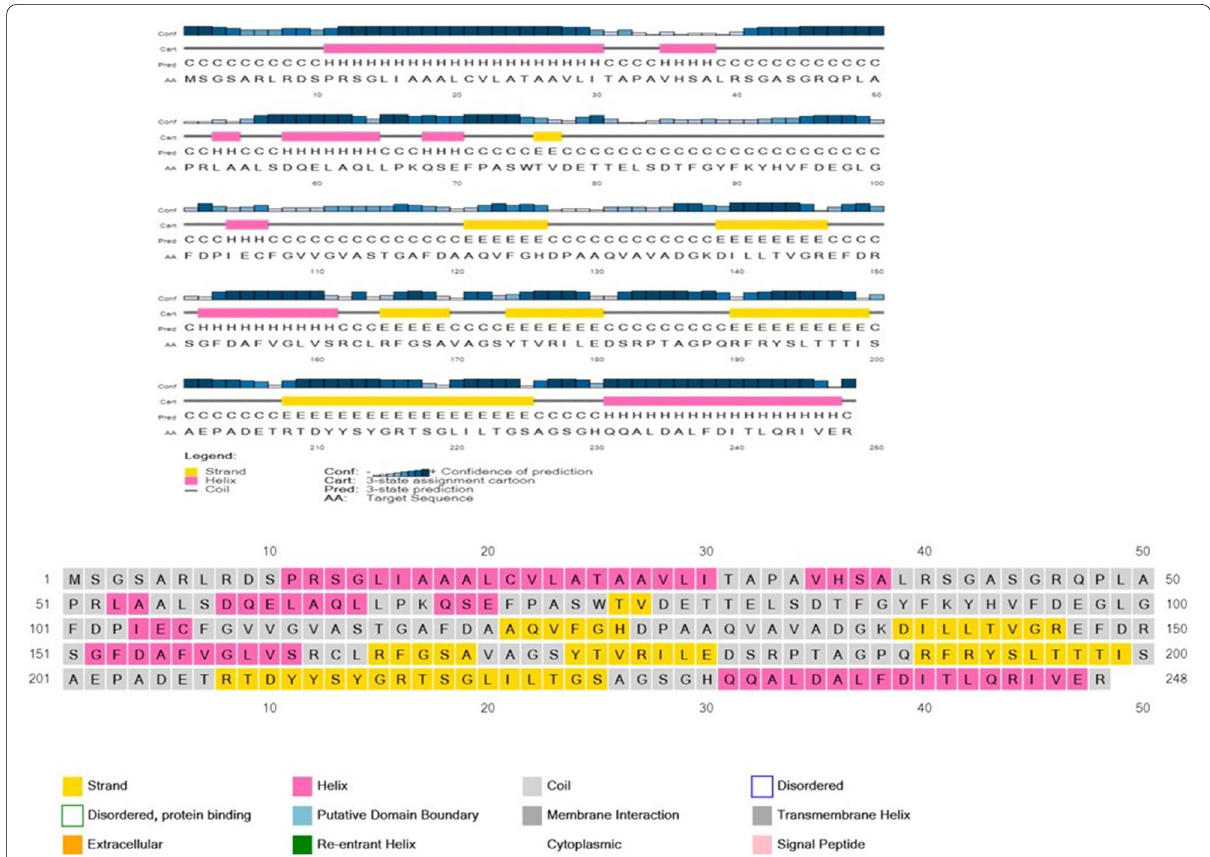
Fig. 5 NHP1 protein secondary structure predicted by PSIPRED server displaying the presence of helix, strands, and random